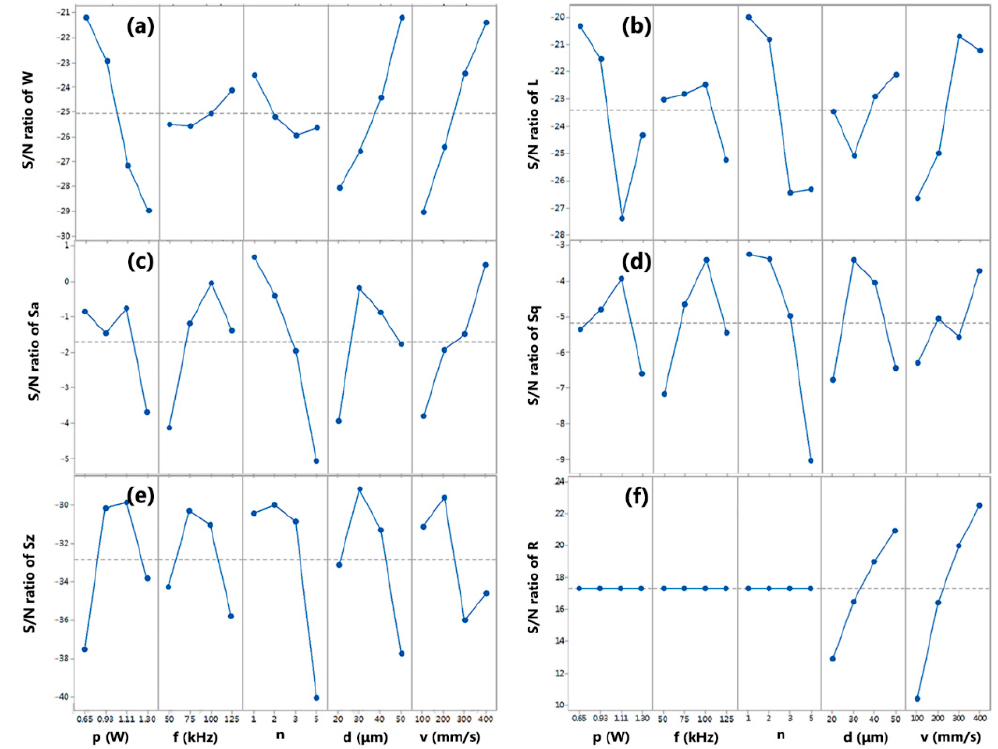
Figure 5. Signal-to-noise e ff ects for laser dicing parameters of p , f , n , d and v on LiNbO 3 cutting characteristics of ( a ) W , ( b ) L , ( c ) Sa , ( d ) Sq , ( e ) Sz and ( f ) R